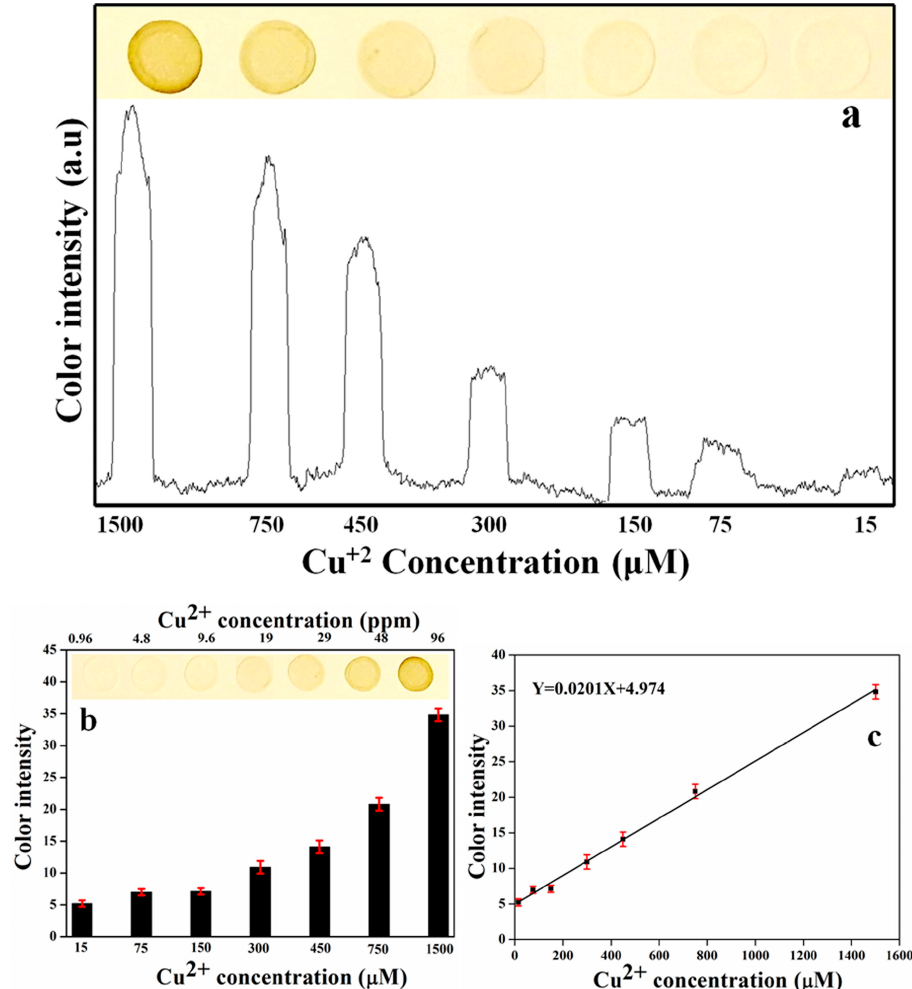
Figure 15. ( a ) Color intensity versus the Cu 2+ ions concentration obtained by ImageJ with a digital photograph as an inset; ( b ) The color intensity versus the Cu 2+ ions concentration; and ( c ) The calibration curve of the color intensity at different concentrations of the Cu 2+ ions. Adapted figure from [103] with permission from copyright (2014), American Chemical Society (Washington, DC, USA).